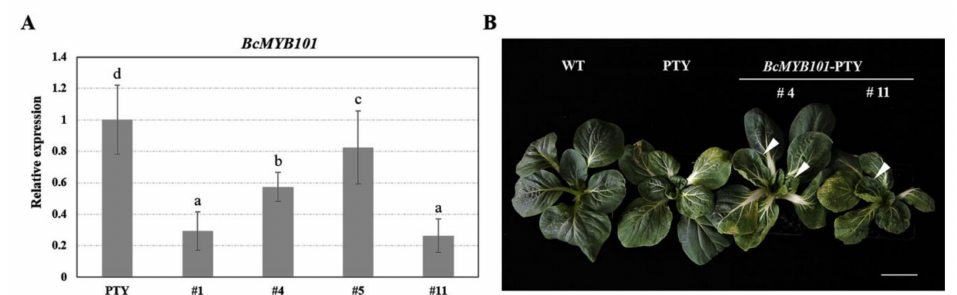
Figure 6. Virus-induced BcMYB101 silencing in pak choi. ( A ) Expression levels of BcMYB101 in gene silencing plants. Error bars represent the standard deviation of the mean number of three replicates. ANOVA was used for statistical analysis. Letters (a, b, c, d) represent the di ff erence of expression level of BcMYB101 gene in PTY and BcMYB101 -silencing plants. ( B ) Upward-curling leaf phenotype in pak choi plants with BcMYB101 silencing. Scale bar = 5